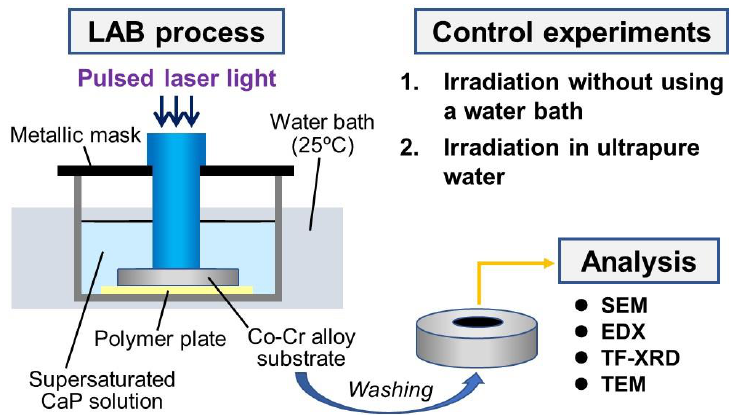
Figure 1. Flow of the study outline and schematic of the experimental setup for the laser-assisted biomimetic (LAB) process for the cobalt–chromium (Co−Cr) alloy